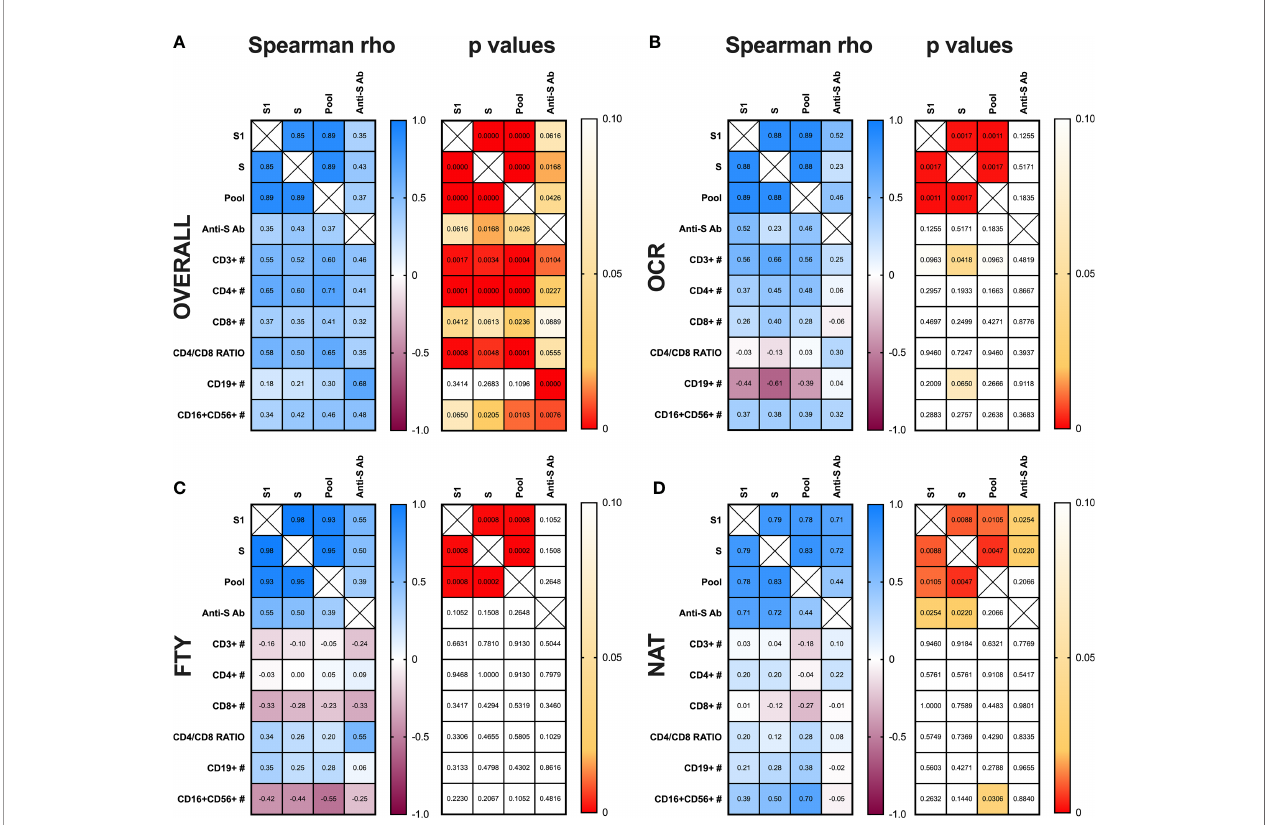
FIGURE 4 | Correlation analysis between T-, B-cell responses and peripheral blood lymphocyte subset absolute counts. Spearman ’ s correlation analysis between IFN- g production upon S1, S, and pooled peptide (Pool) stimulation of whole blood, anti-S antibody (Ab) titers, T- (CD3+, CD4+, CD8+), B- (CD19+), NK- (CD16+CD56+) cell absolute counts and CD4/CD8 ratio in peripheral blood are represented for the overall cohort of PwMS (A) and the three subgroups of subjects on ocrelizumab (B) , fi ngolimod (C) and natalizumab (D) treatment. (A – D) . Spearman rho coef fi cient are reported in the left grid while the corresponding p values are represented in the right grid for each panel of the fi gure. PwMS, people with multiple sclerosis; OCR, ocrelizumab group; FYT, fi ngolimod group; NAT, natalizumab